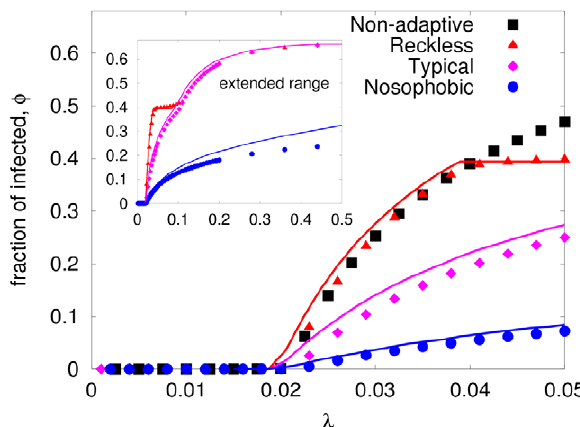
Figure 4. Non-adaptive and adaptive preferred degree SIS phase diagram. We have chosen N ~ 5000 , k 0 ~ 25 and k min ~ 10 for all three adaptive models (See Figure 3). The solid lines represent the mean field solution to these models based on Eq. 6.